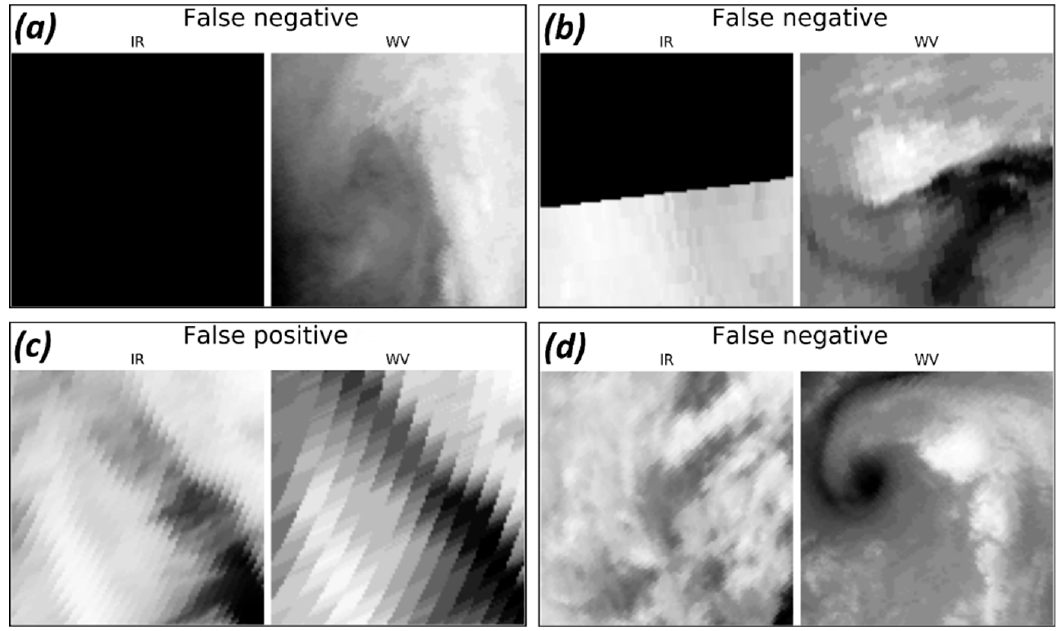
Figure 5. Examples of false classified objects, for which ( a , b ) IR satellite data is missing or corrupted, ( c ) the source satellite data is suspected to be corrupted, ( d ) the source satellite data is realistic, but the classifier has made a mistake.